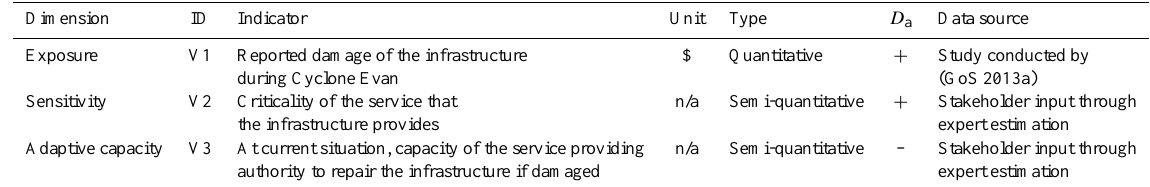
Table 1. Vulnerability indicators of SIVM.